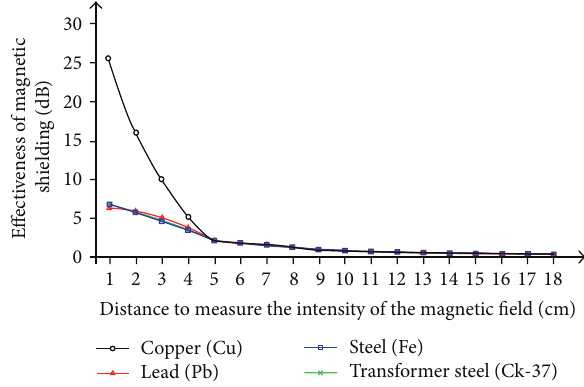
Figure 3: The effectiveness of magnetic field shielding of various materials that were tested. The horizontal axis represents the distance of the rectangular shielding plate, and the vertical axis shows the effectiveness of the shielding for various